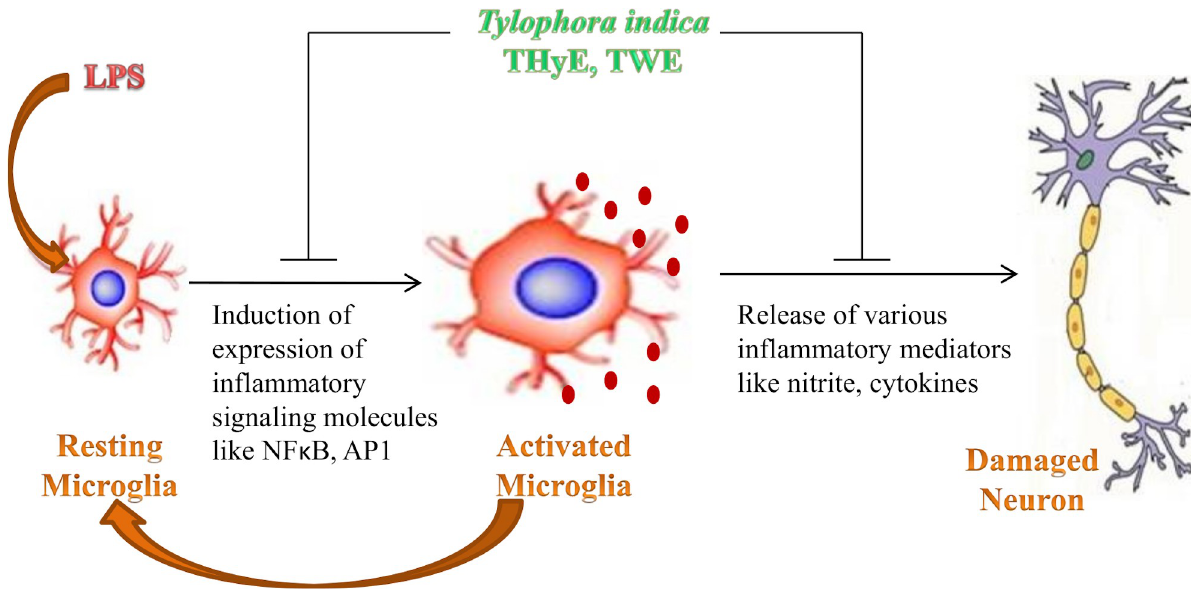
Fig 6. Graphical representation depicting the anti-neuroinflammatory activity of Tylophora indica against LPS induced inflammatory responses and possible molecular mechanisms.